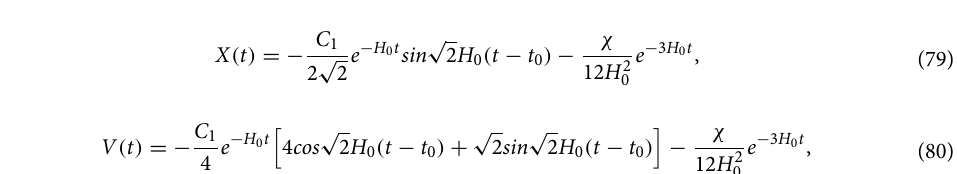
4, 4 ) in the de-Sitter reconstructed ( ∈ −